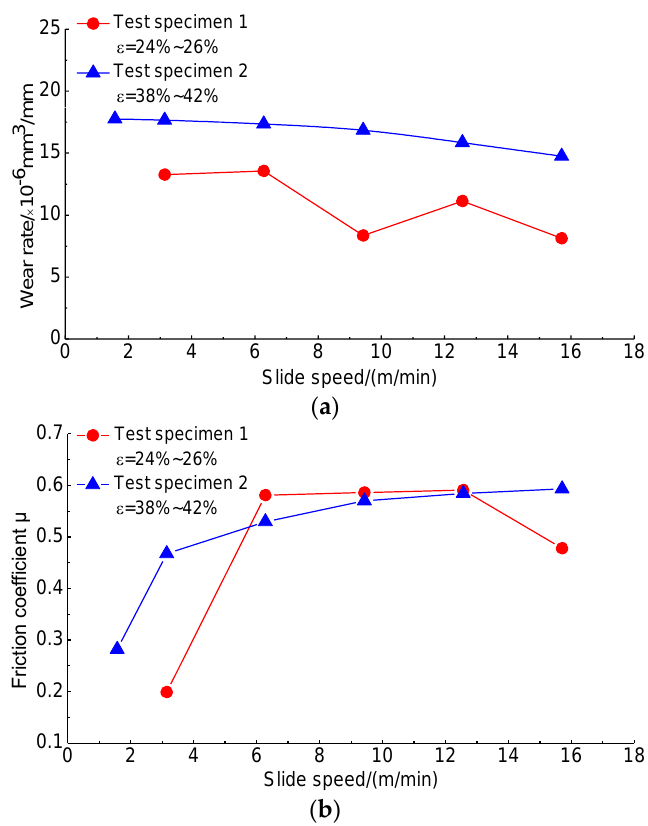
Figure 9. The variation curves of the wear rate and friction coefficient with the sliding speed: ( a ) relationship between the wear rate and sliding speed of materials with different porosities; and ( b ) relationship between the friction coefficient and sliding speed of materials with different porosities.